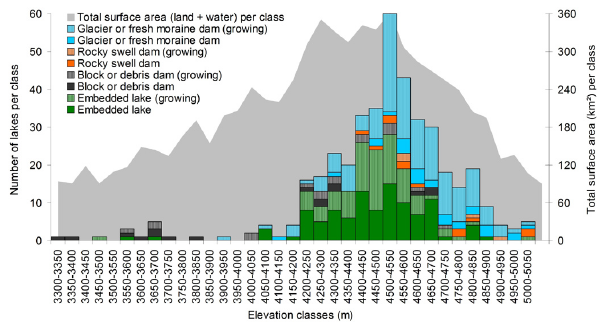
Fig. 6. Distribution of lake types and lake evolution plotted against elevation. The distribution of the total surface of the study area is shown as